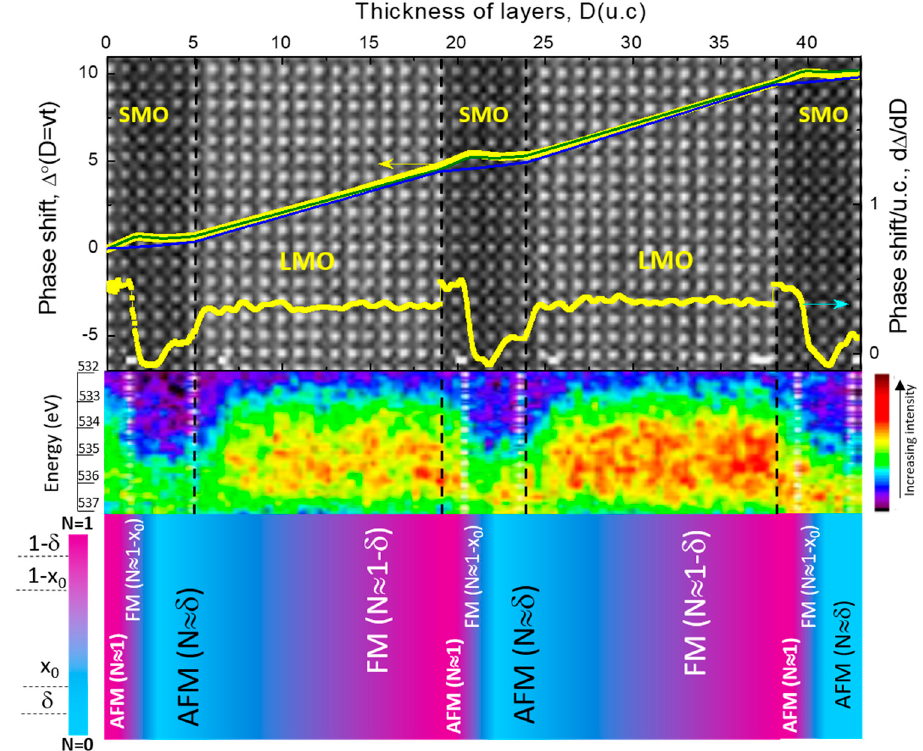
Figure 13. Top panel: Phase shift ∆ ( D ) (left scale) in SL n = 5, superimposed onto the HAADF HRTEM image. The experimental “yellow” curve is nicely reproduced by the simulated “green” one assuming an electron transfer within the first 2 u.c. of SMO. Without charge transfer, the simulated “cyan” curve does not fit the measured (“yellow”) one. The phase shift / unit cell (“yellow” curve, right scale), d ∆ / dD , reflects the evolution of electron density in LMO / SMO layers. Middle panel: The 2D distribution of the electron-energy-loss spectra (EELS) of the O K edge structure for energies E = 532–537 eV along the growth direction shows the electron- (“yellow”) and hole-rich (“blue”) regions within the SMO and LMO layers, respectively. The EELS intensity increases from “blue” to “red”. Bottom panel: Qualitative model of the inhomogeneous electron density distribution along the growth direction: high-temperature (HTP) and low-temperature (LTP) ferromagnetic (FM) phases (“red” regions) are separated by two AFM phases: electron-rich (“red”) in SMO and hole-rich (“blue”) in the SMO and LMO. “Reprinted figure from [34] under permission licensed by John Wiley and Sons (Nr. 4654230253827)”.